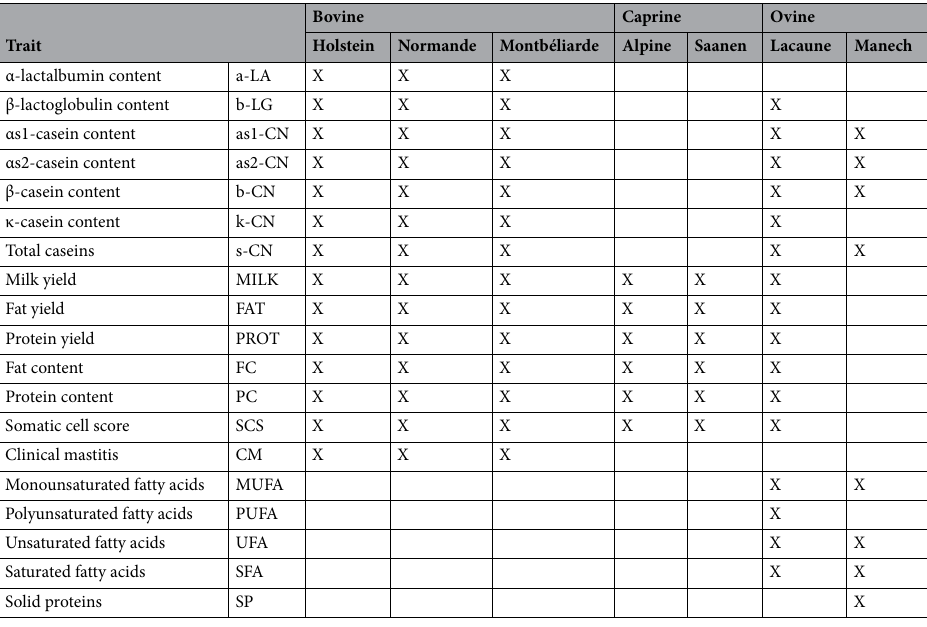
Table 5. Dairy traits affected by the quantitative trait loci, with the breed for bovine, caprine, and ovine species. The abbreviations of the trait annotations are specified in the